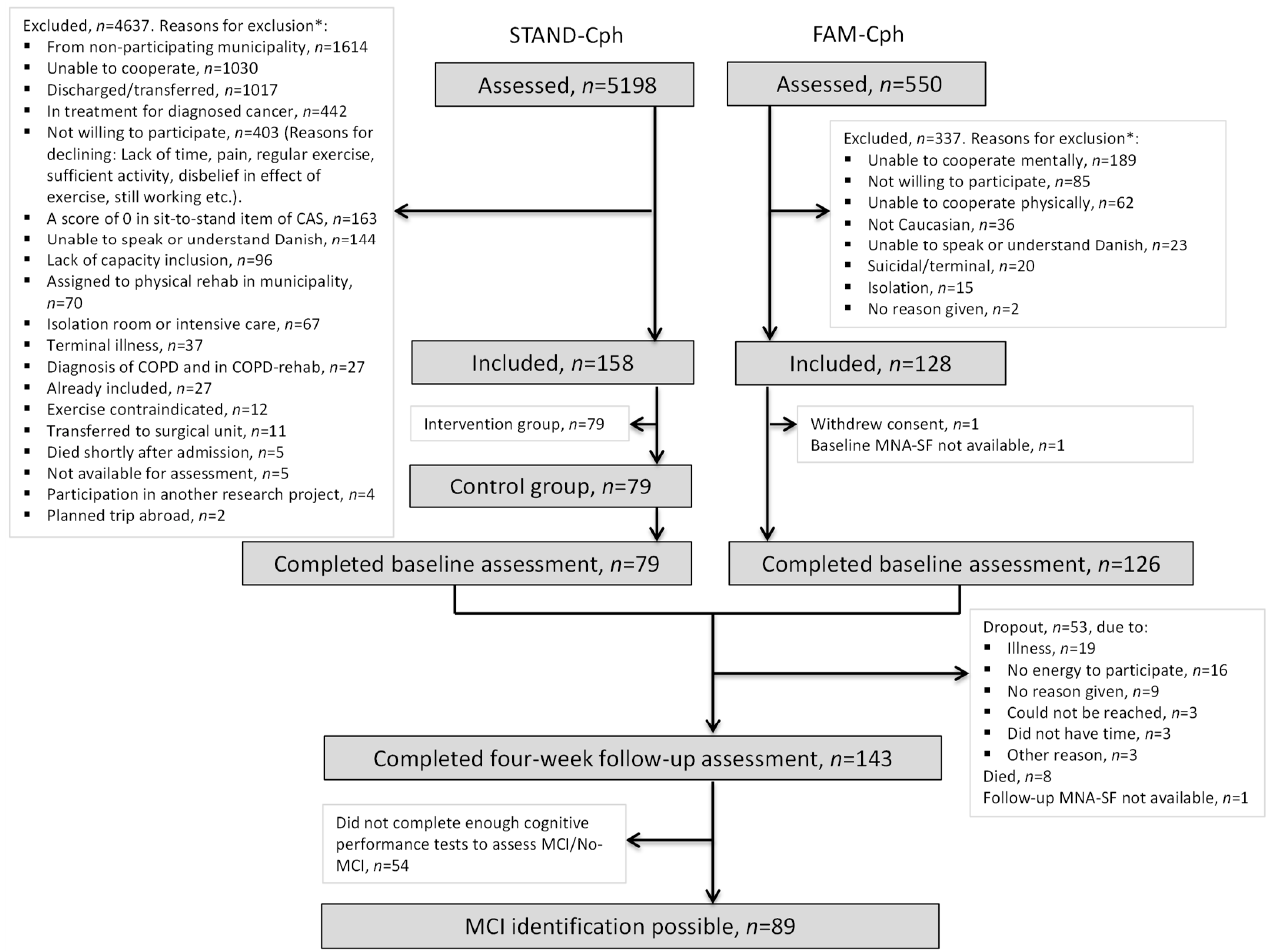
Figure 1. Flowchart. * Patients can have more than one reason for exclusion. Table 1. Characteristics of the study participants at 4-week follow-up ( n =